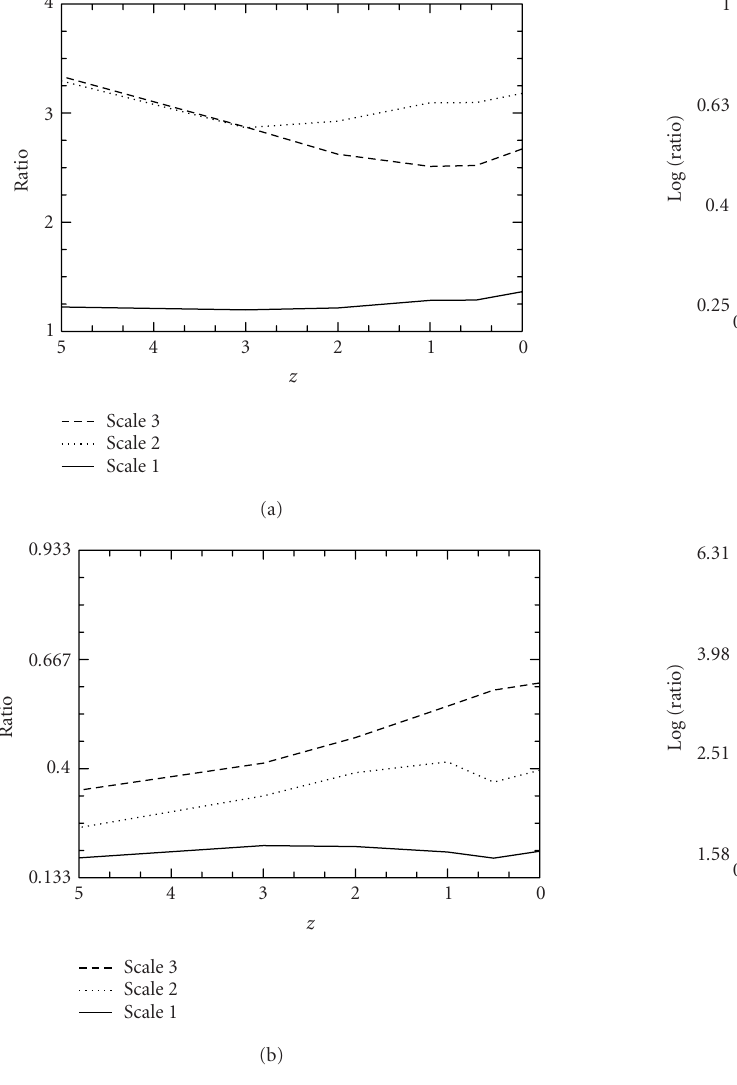
Figure 17: (a) Beamlet/wavelet 1 /M w/b ( z , j ) and (b) ridgelet/ wavelet 1 /M w/r ( z , j ) curves at di ff erent